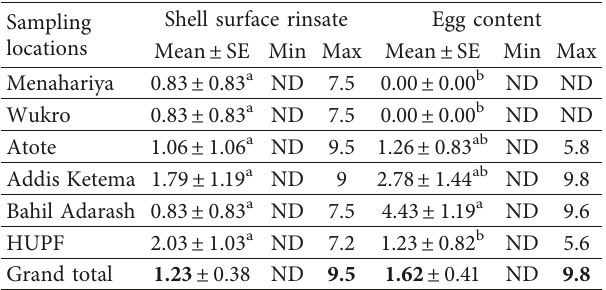
Table 8: Fecal coliform count (FCC) in log surface rinsates and contents of egg samples in Hawassa City, southern Ethiopia, 2019.